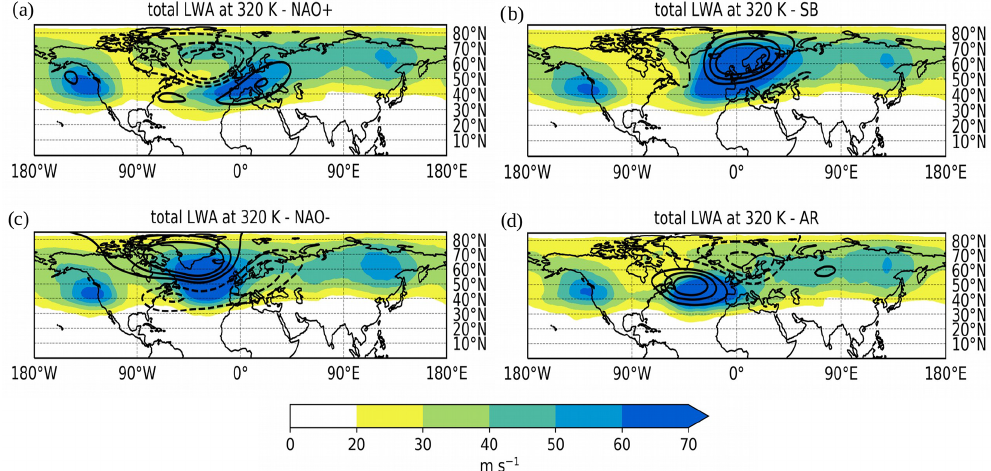
Figure 5. Total (i.e. stationary and transient) LWA (colour, units ms − 1 ) and Montgomery stream function anomalies (black contours at 500, 1000 and 1500m 2 s − 2 ; dashed contours represent negative values; the zero contour is omitted) at 320K associated with the four WRs over the EAT sector during winter in